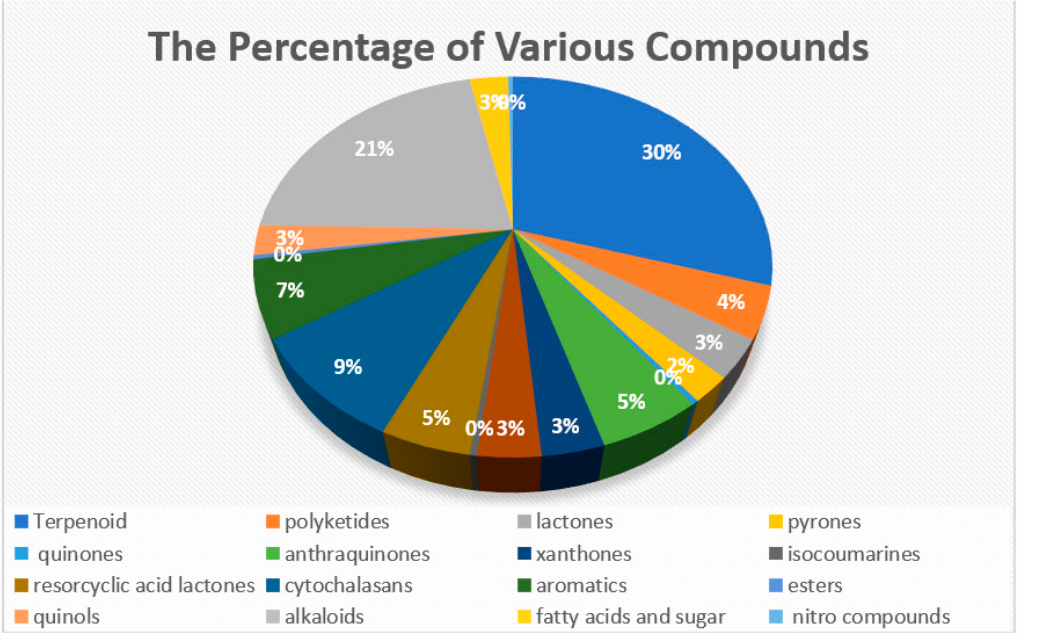
Figure 1. The percentage of various compounds which have been isolated from endophytic fungi in Meliaceae [31–63].